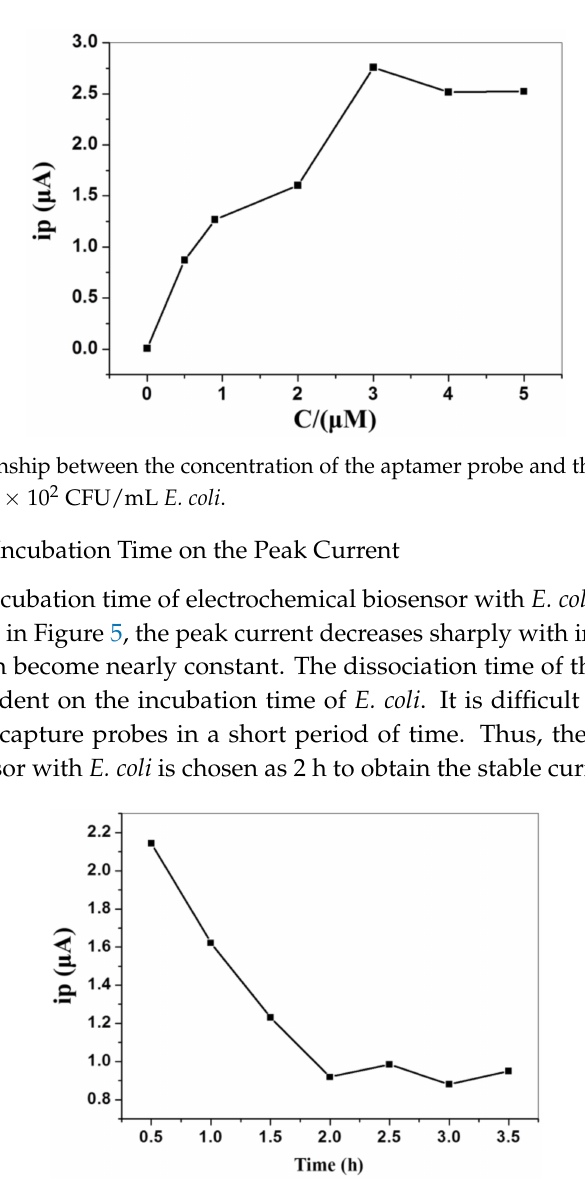
Figure 5. The relationship between the incubation time and the peak current under reaction with 5.0 × 10 3 CFU/mL E. coli and 3 µ M aptamer